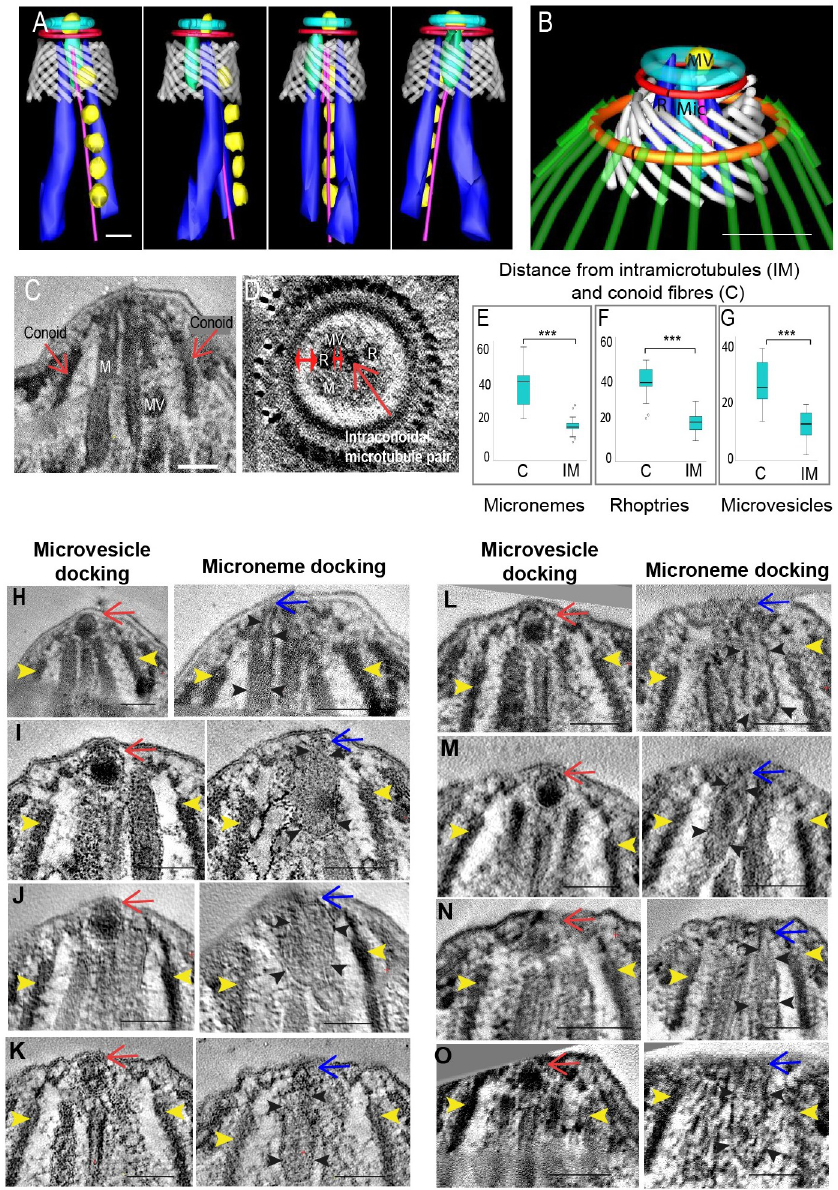
Fig 2. Secretory organelles and their association with the intra-conoidal microtubules and overlying the plasma membrane. A: Series of rotational views of a segmentation created from one serial section dual axis tomogram illustrating the spatial grouping and alignment of microneme (light green), rhoptries (dark blue) and MVs (yellow) with the intra-conoidal microtubule pair (pink); B: Segmentation of a serial section dual axis tomogram illustrating the relative positioning of a microneme (light green), rhoptry (dark blue) and MVs (yellow) within the conoid area of the parasite; C and D: slices taken from different tomograms (C) longitudinal view and (D) cross section view illustrating how measurements were taken showing the distances from a microneme (M), rhoptry (R) and microtubule-associated vesicle (MV) to either the intra-conoidal microtubules or conoid. Double-headed red arrows in (D) show where the measurements were taken, single arrow in C for the identification of the conoid in longitudinal sections. Single arrow in D is the location of intra-conoidal microtubules; E-G: Micronemes, MVs and rhoptries were significantly closer to the intra-conoidal microtubules (IM) than to the conoid (C) (t-test, p < 0.0001) (N = 17); H—I: Longitudinal slice views from 8 serial section tomograms illustrating a MV (red arrows), microneme (blue arrows and black arrowheads) in close association with the plasma membrane overlying the conoid in each tomogram. Yellow arrowheads show the outer edge of the conoid in each example. Scale bars– 100nm.